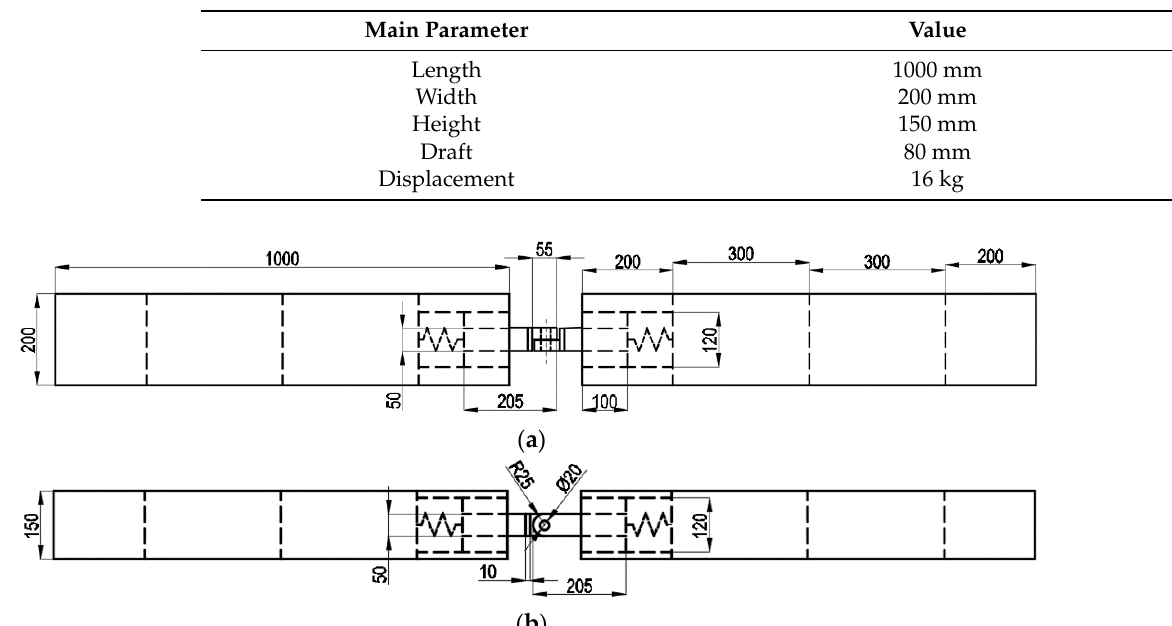
Table 1. Main dimensions of a single module model.